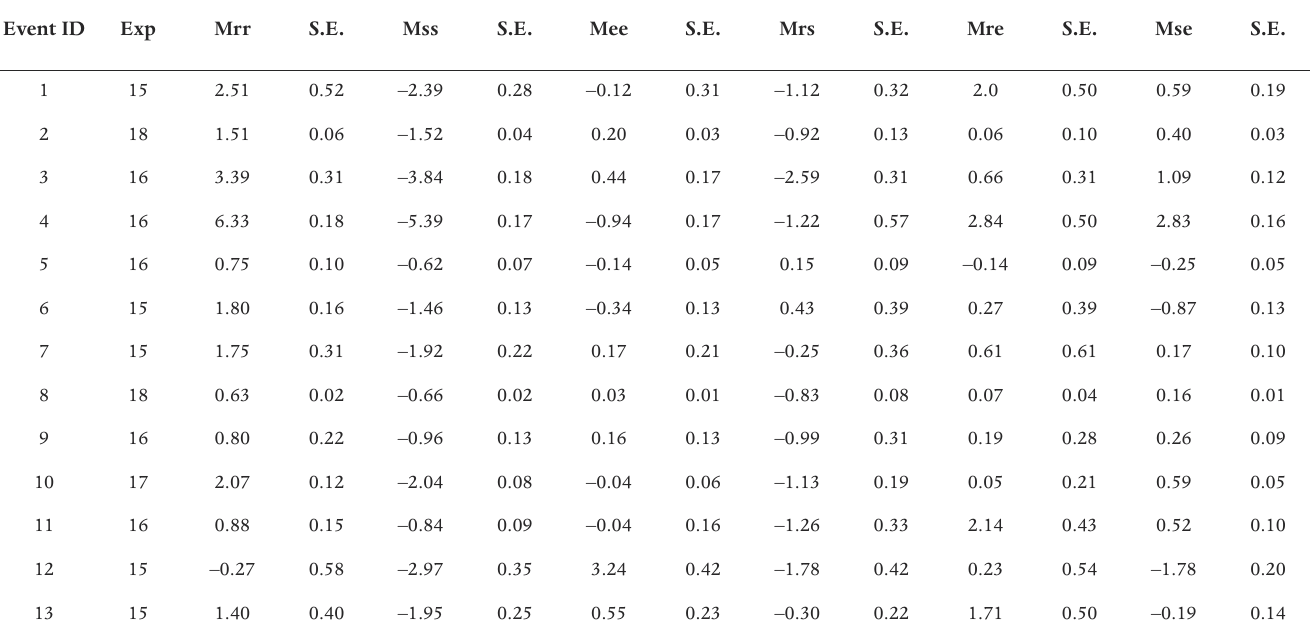
Table 2. Exponent and moment tensor elements, together with their standard